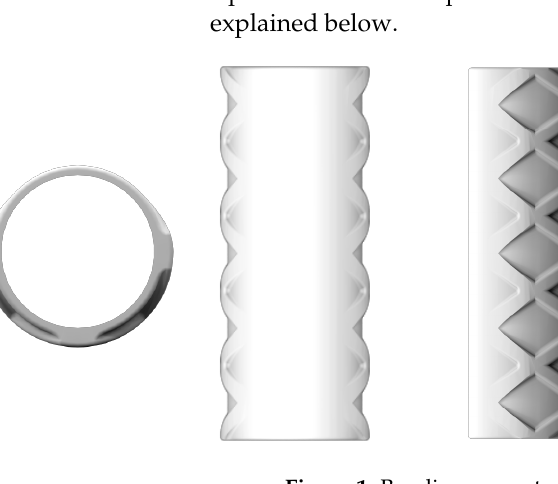
Figure 1. Baseline geometry of the stent